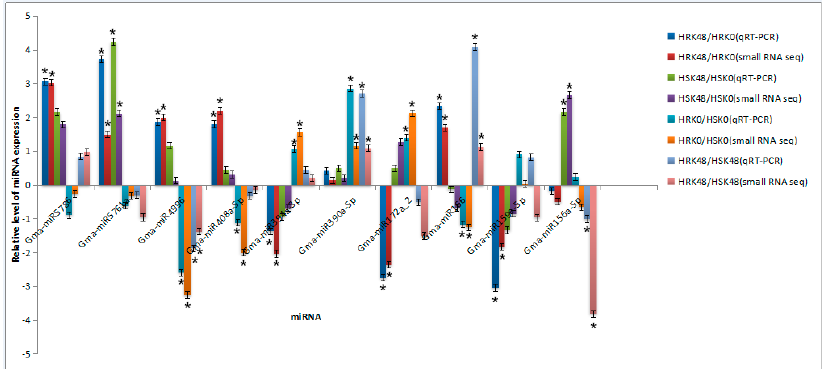
Figure 3. Verification results of differentially expressed miRNAs. Note: “*” representing p ≤ 0.01, respectively, which indicated significant difference level.